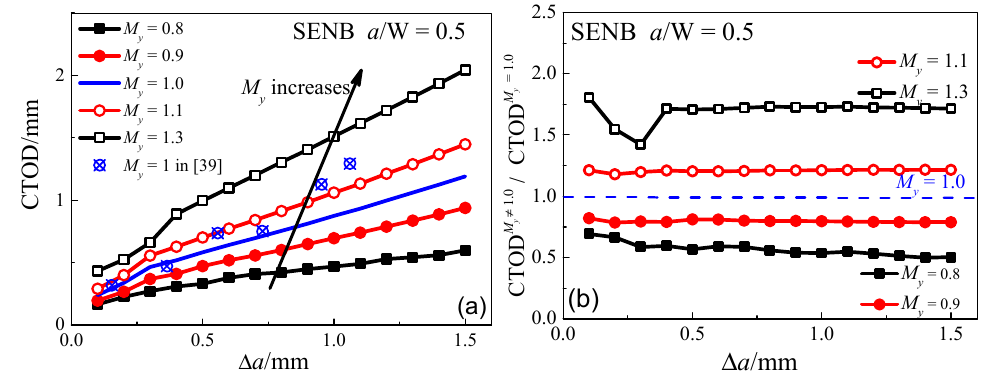
Figure 4. Effect of strength mismatch on crack growth resistance, ( a ) ductile resistance curves; ( b ) normalized crack growth resistance curves.